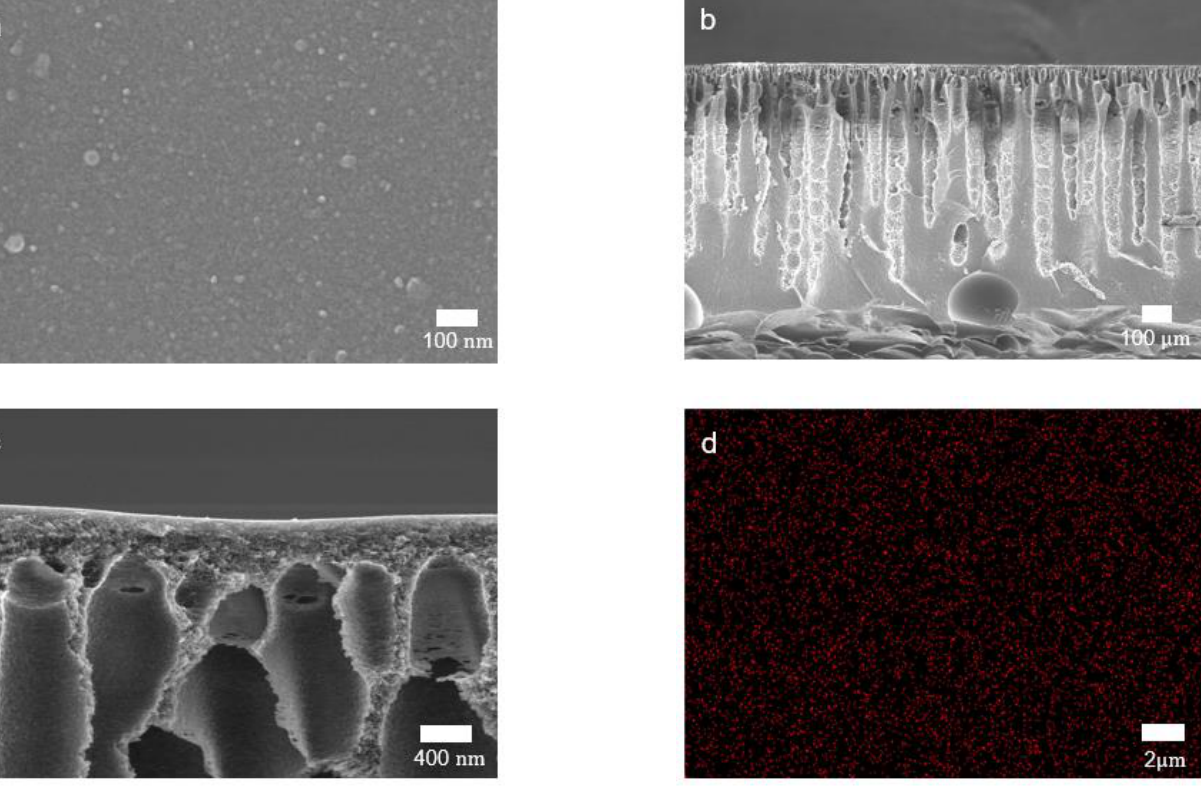
Figure 4. SEM images of crosslinked PBI membranes. ( a ) Surface and ( b ) cross-sectional images of overall morphology; ( c ) cross-sectional image of the skin layer; ( d ) EDX elemental mapping of silicone on the membrane surface.